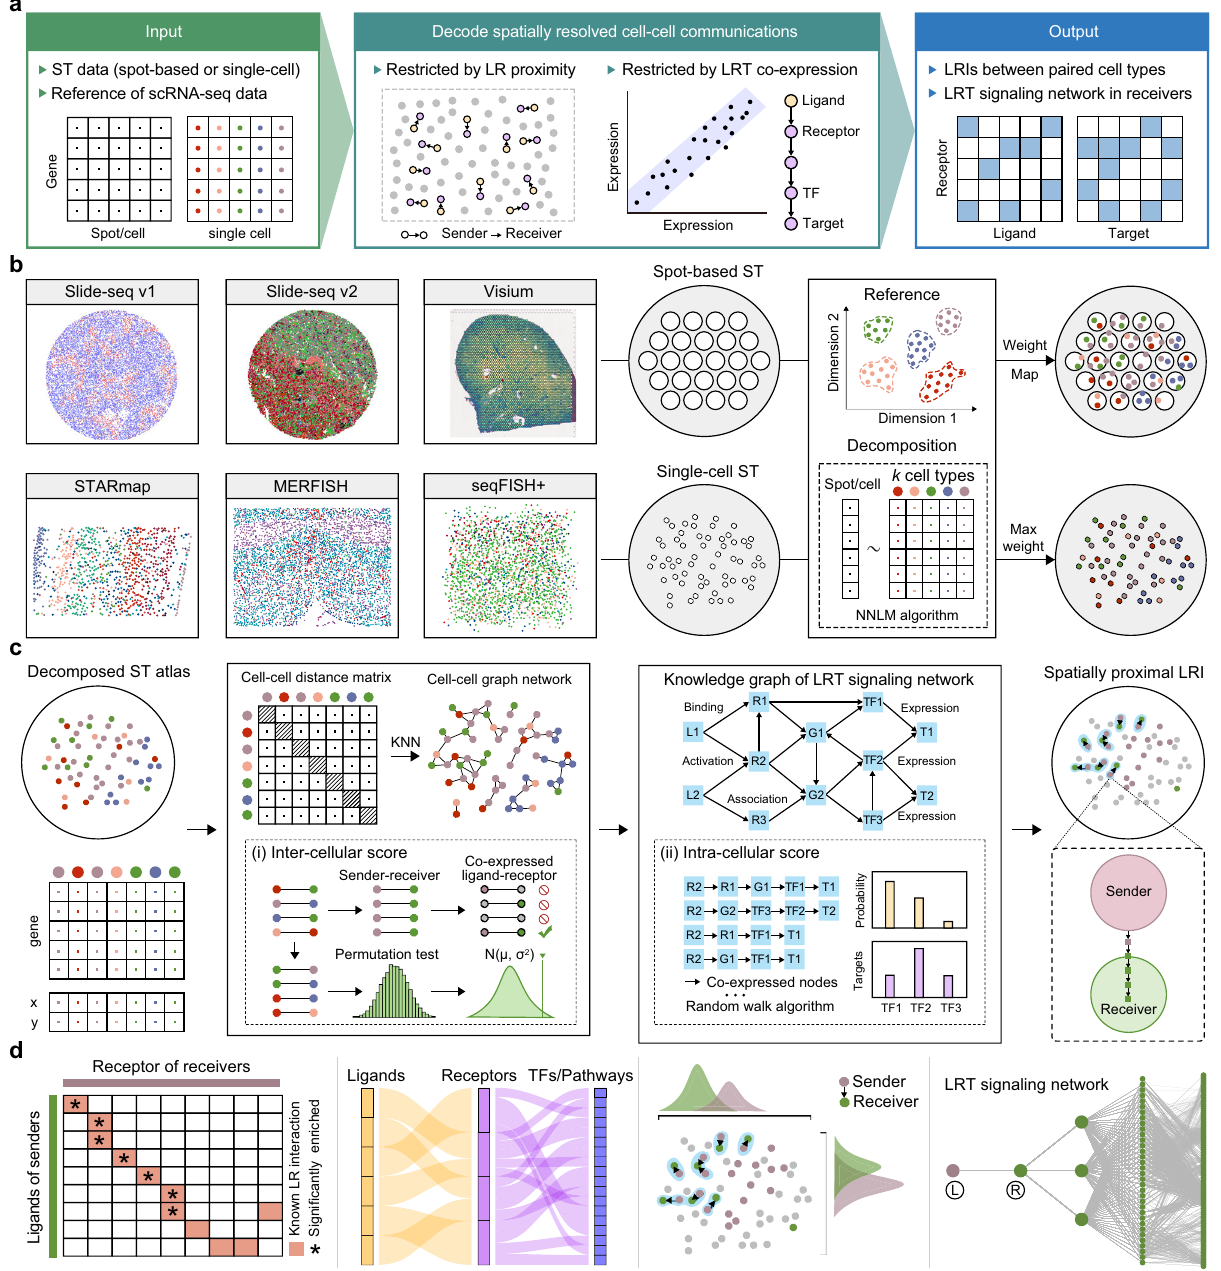
Fig. 1 | Work fl ow of the SpaTalk method and visualization. a Overview of SpaTalk, including the input, intermediate process of decoding spatially resolved cell – cell communications, and output. b Conceptual framework of cell-type decomposition with SpaTalk. Five different spatial technologies and datasets were selected and analyzed: spot-based ST data (Slide-seq and 10x Visium) and single-cell ST data (STARmap, MERFISH, and seqFISH+). NNLM was used to dissect the optimal proportion of cell types for the projection of cells from scRNA-seq reference data onto the spatial cells/spots, generating single-cell ST data with known cell types. c Schematic representation of